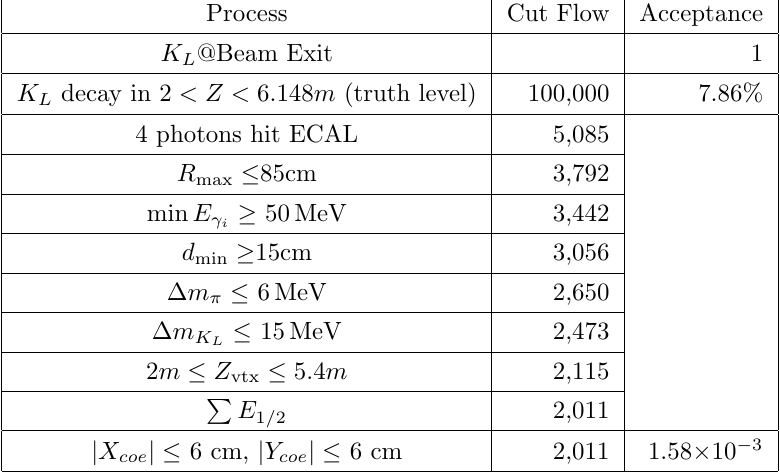
Table 2 . Decay probability, cut (cid:13)ows, and acceptance of our K L ! (cid:25) 0 (cid:25) 0 analysis. C (cid:1) S = 1 transitions and ALP coupled to